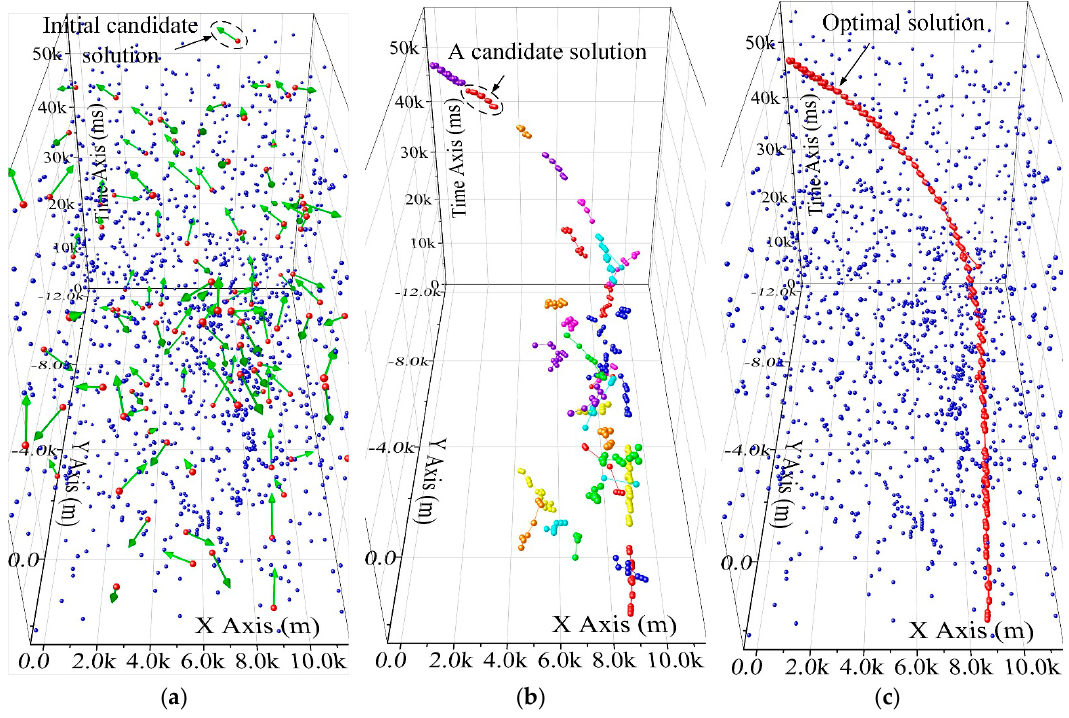
Figure 5. The utilization of the GWO-TBD in a real scenario. ( a ) The initial candidate solutions. ( b ) The candidate solutions in the iteration. ( c ) The optimal solution.